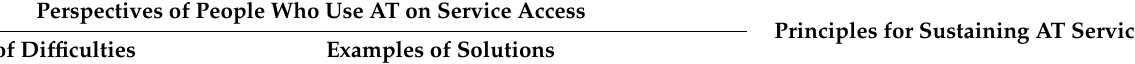
Table 3. AT service access difficulties, and